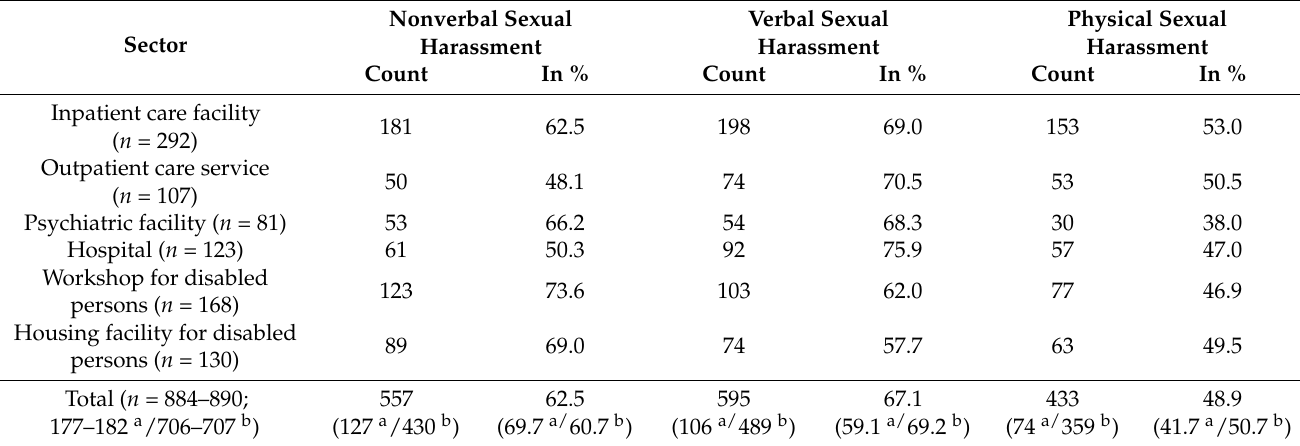
Table 3. Prevalence of sexual harassment in the healthcare and social services